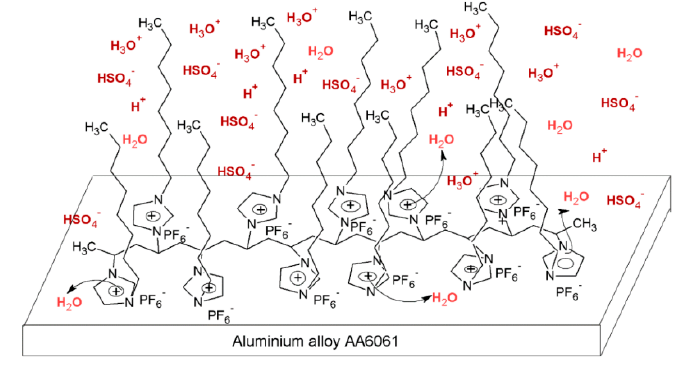
Figure 3. PIL adsorption diagram [30].